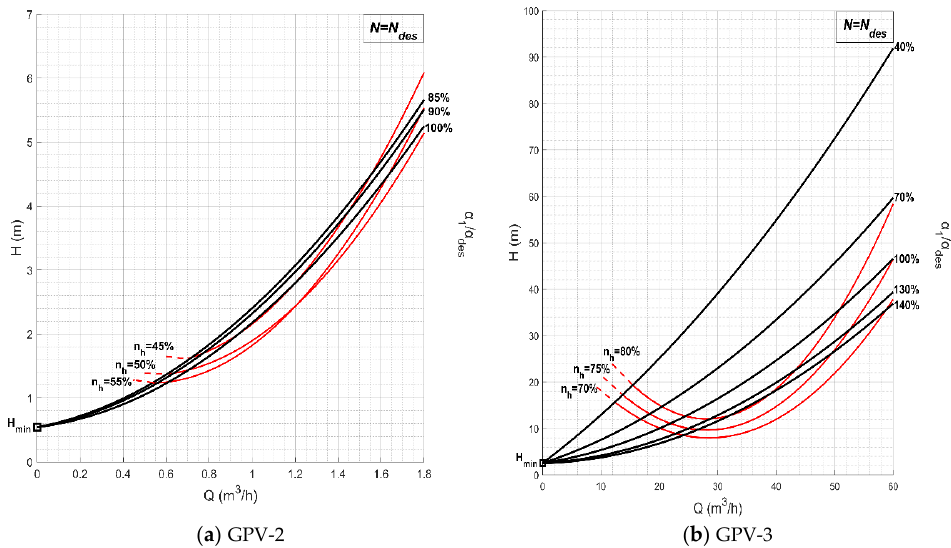
Figure 11. Turbine constant speed performance curves as a function of water flow rate and angle α 1 values for the cases of GPV-2 and GPV-3. values for the cases of GPV-2 and